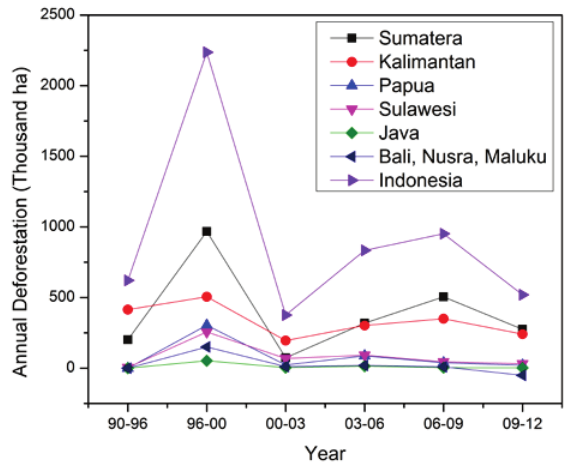
Figure 2 Annual deforestation estimate across main Islands of